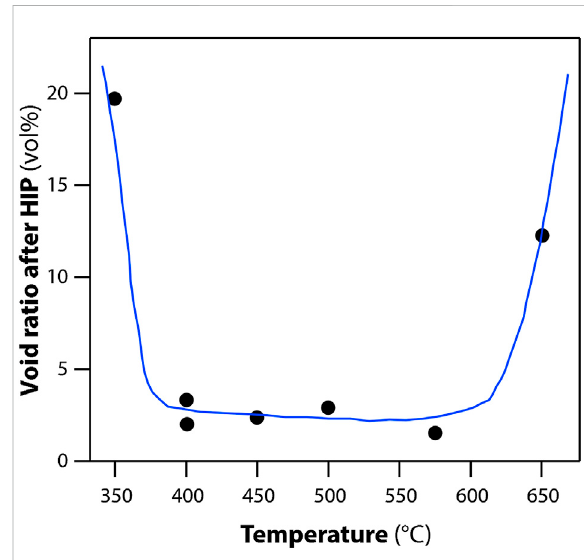
FIGURE 9 Effect of temperature during vacuum pretreatment on void ratio of solidi fi ed body. Pre-treatments: degassing under 5 × 10 – 4 Pa for 2 h at various temperatures; HIP treatments: 1200 ° C and 175 MPa for 3 h (Masuda et al.,